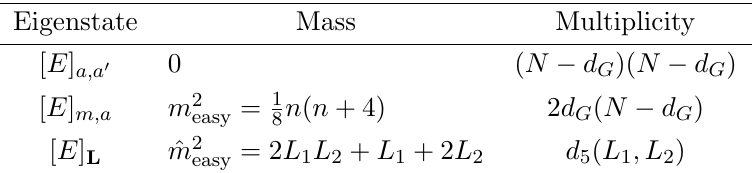
Table 2 . Masses of the easy bosons E = A 0 ; A 1 ; A 2 ; ~ (cid:30) 6 . The allowed ranges of L 1 and L 2 are 0 (cid:20) L 2 (cid:20) L 1 , L 1 + L 2 (cid:20) n . The de(cid:12)nitions of d 5 and d G can be found in (1.1) and (A.8),